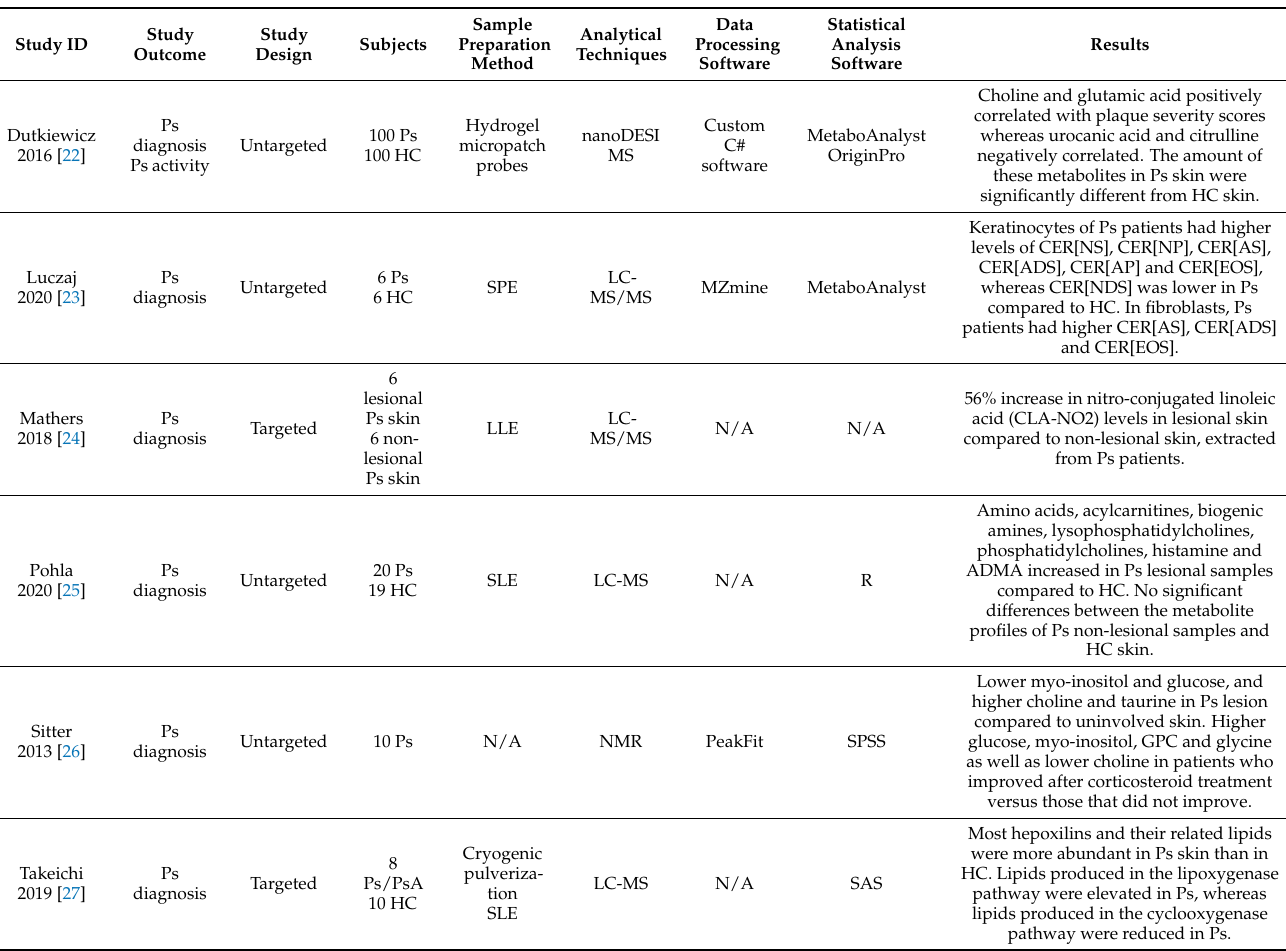
Table 5. Studies in